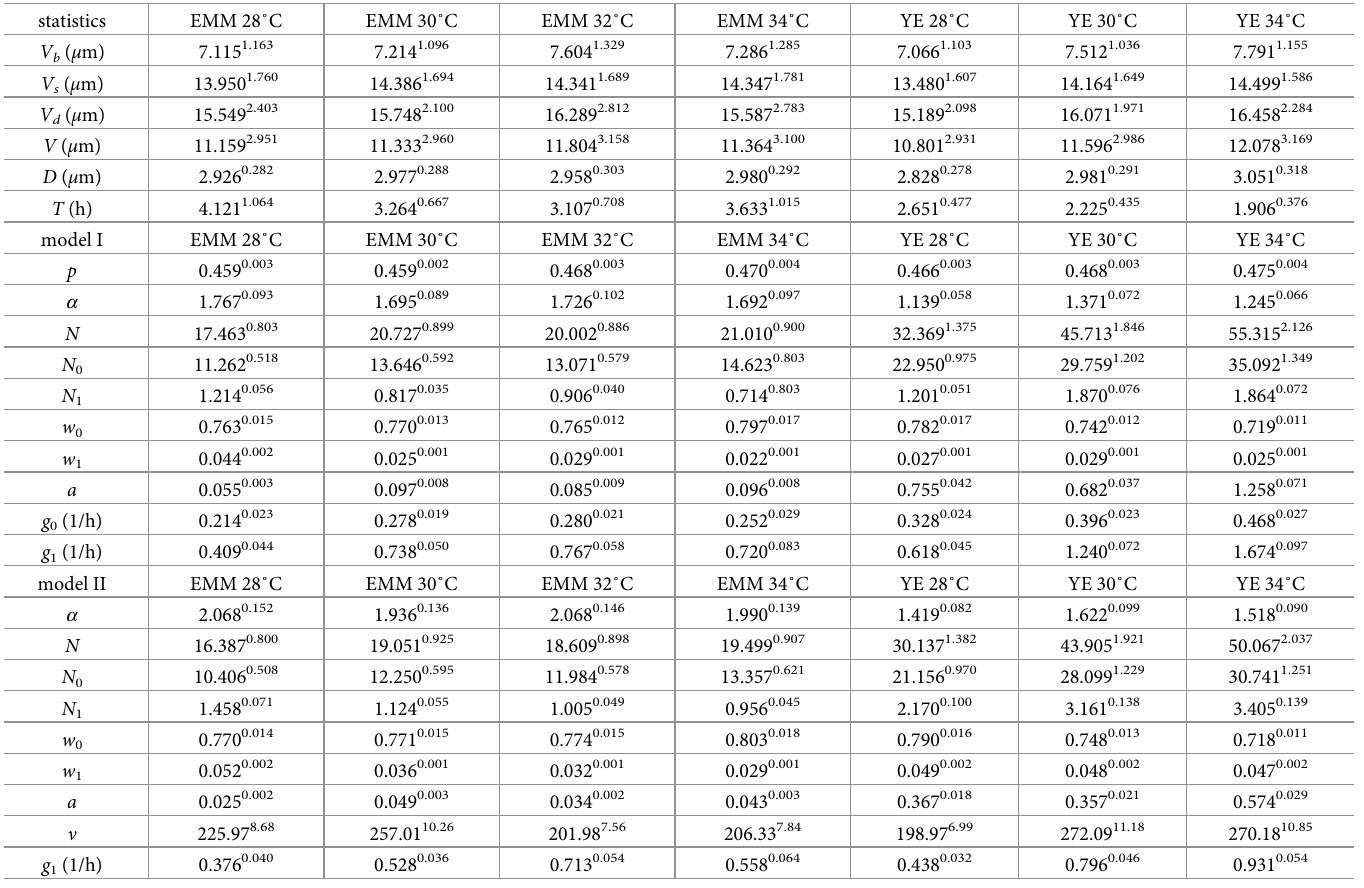
Table 2. Parameters estimated using lineage data of cell length under seven growth conditions. The mean and standard deviation (upper-right corner) of six variables are given: the birth size V b , the septation size V s , the division size V d , the cell size V , the cell diameter D , and the doubling time T . We perform parameter inference for both model I and model II. The estimation error for each parameter was computed using bootstrap. Specifically, we performed parameter inference 50 times; for each estima- tion, the theoretical model was fitted to the data of 50 randomly selected cell lineages. The estimation error was then calculated as the standard deviation over the 50 repeated samplings. The estimates of p and g 0 are the same for both models and thus we only list their values for model